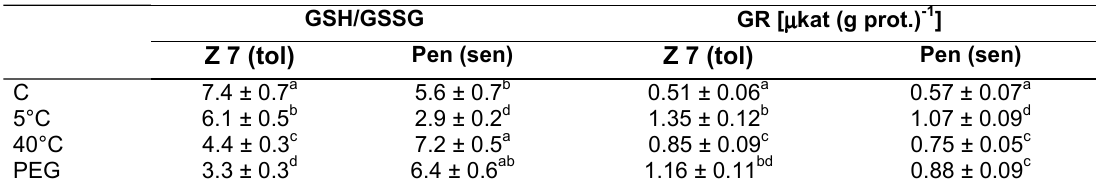
Effect of Abiotic Stresses on the Ratio of Reduced to Oxidised Glutathione and on the Glutathione Reductase Activity in Shoots of a Chilling-Tolerant Maize Line, Z 7, and a Chilling-Sensitive Penjalinan